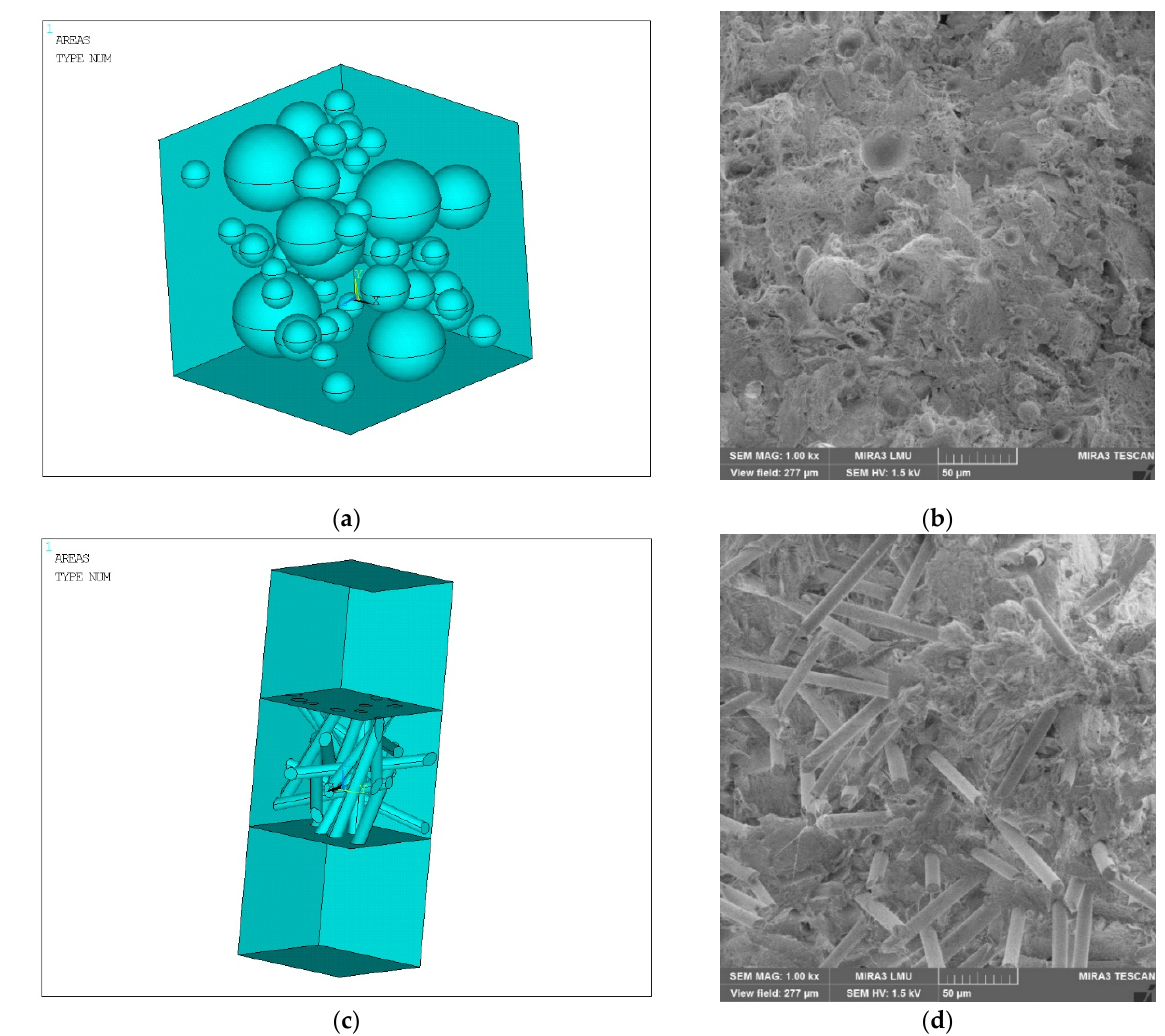
Figure 2. Solid model of composite materials, chaotically reinforced with spherical and cylindrical inclusions ( a , c ) (all areas of the simulated volumes are shown, except the ones closest to the observer) and real microstructures of PTFE composite with 20% coke ( b ) and 15% CF ( d ).